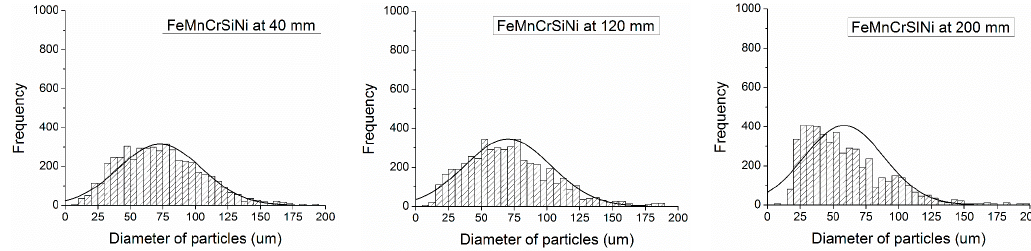
Figure 4. Histograms of diameter of particles observed in different distances from the gun.